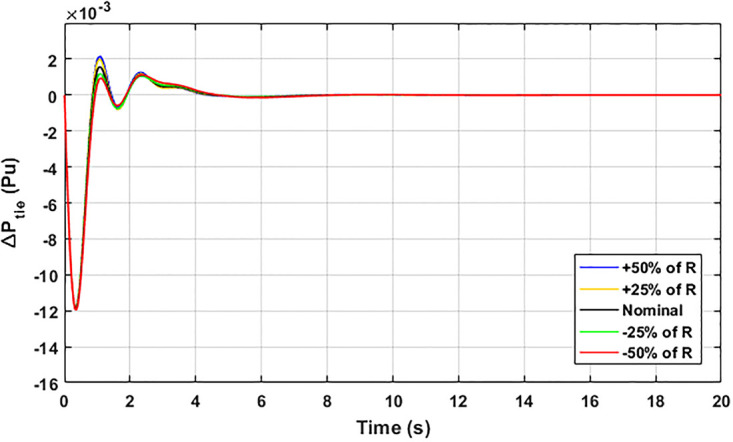
Results for variation in R with ΔPtie.